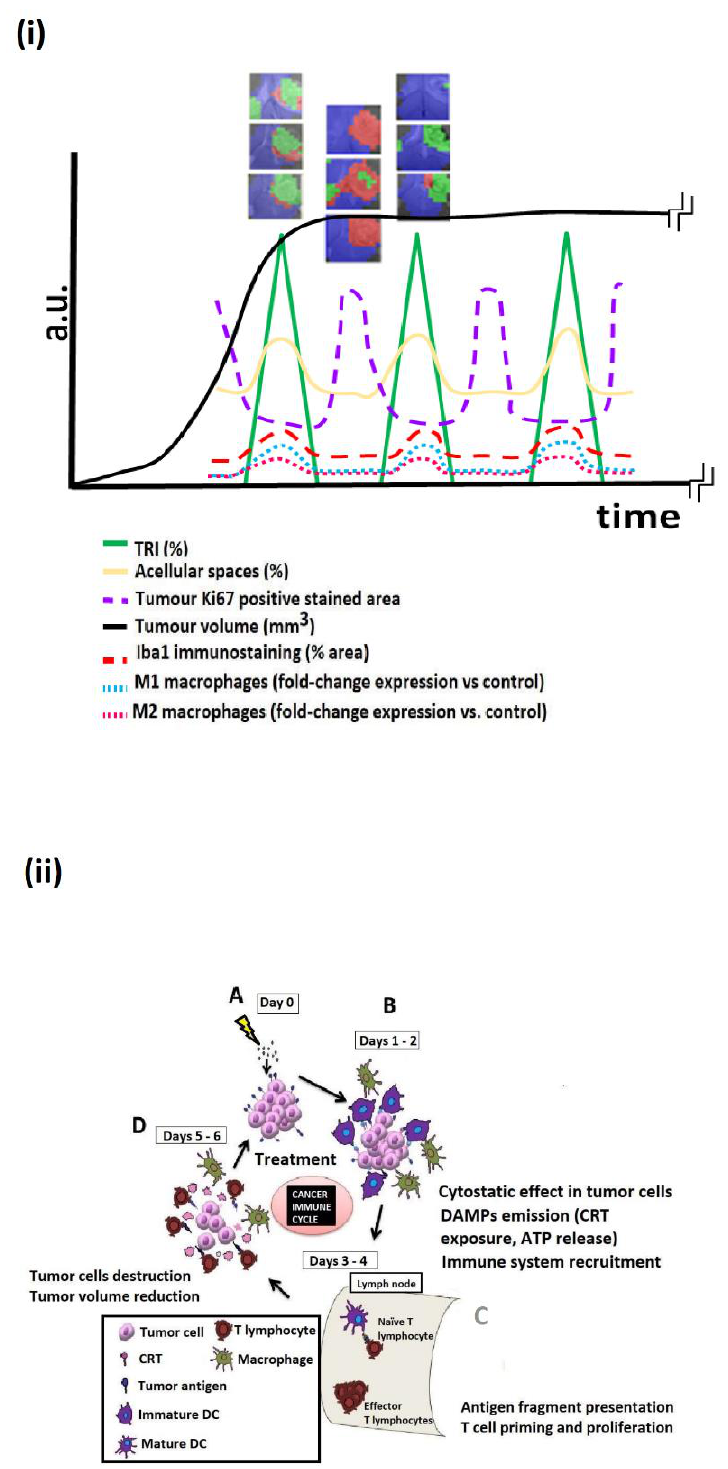
Figure 3. ( i ) Tentative summary of the main cellular/molecular features changing during GB treat- ment and the associated changes in the MRSI-detected metabolome pattern described by our group. Representative nosological images were obtained from Immune-Enhancing Metronomic Schedule (IMS)-TMZ treated case C1264 [57] during a transient response to therapy (i.e., stable tumor volume, black solid line). The TRI oscillations (green solid line) are an average representation of transiently responding cases reported in our previous work [43,57]. Acellular spaces (dark blue solid line), the Ki67-positive stained area (purple dashed line), and the Iba-1 stained area (brown dashed line) were estimated from fields of histopathological slides from high-level response ( n = 27 fields) and control cases ( n = 40 fields) described in [43]. M1 and M2 macrophages ’ gene level expression changes (light blue and pink dashed lines) were calculated from NOS2 and CD206 obtained from IMS-TMZ treated and control tumor samples ( n = 10 each) described by us in [56]. ( ii ) Schema of cancer immune cycle (reproduced with permission from [57]) starting from (A) treatment (e.g., in this example, IMS- TMZ), which triggers immunogenic cell death/damage, (B) release of DAMPs (CRT, calreticulin)